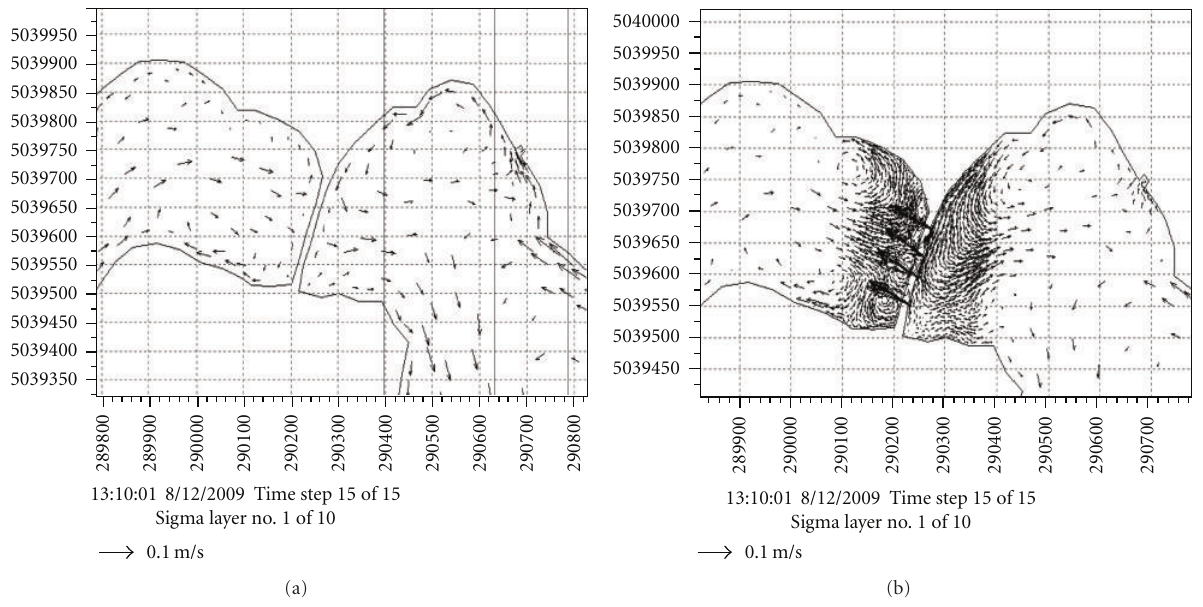
Figure 26: The bottom flow patterns under strong easterly wind with the closed and 4 inserted culvert causeway structures.